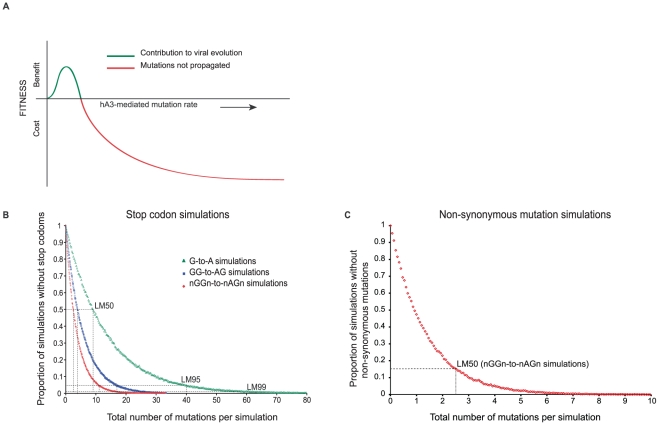

In silico simulation of hA3G-induced mutation in HIV(IIIB) open reading frames.A. Proposed relationship between viral fitness benefit and cost and hA3G mutation rate modified from [3]. When hA3G edits HIV-1 genomes above a particular editing rate, the mutational burden will be too high for the virus and a fitness cost is incurred, depicted in red. However, within a hypothetical window of hA3G activity, marked by the blue line, the extent of editing induced might be low enough for the virus to survive. The additional mutations may help the virus adapt faster in a fluctuating host environment and thus may be considered a viral fittness benefit. B. Each curve represents 100,000 in silico simulations of hA3G-induced mutation of the HIV(IIIB) open reading frames (the virus used in all in vitro experiments) at 100 incremental mutation rates, at which the proportion of sequences escaping in-frame stop codons was assessed. The number of mutations on the x-axis corresponds to the product of the mutation rate and the total number of available targets. Simulations using three different nucleotide targets were performed; (i) G-to-A mutation (n targets = 1362), (ii) GG-to-AG mutation (n targets = 667), and (iii) nGGn-to-nAGn mutation (n targets = 662, with 16 specific nGGn mutation rates from [20]). G-to-A simulations assumed that hA3G would recognized all Gn dinucleotide targets equally, GG-to-AG considered hA3G's preferred di-nucleotide target, while nGGn-to-nAGn simulations considered the 16 previously defined hA3G mutation rates [20] and thus more accurately mirrored the specificity with which hA3G induces mutations in vivo. The number of mutations necessary to induce a stop codon in 50% of viral offspring (LM50) decreased as the accuracy of the hA3G target increased from a single G to a di-nucleotide motif and lastly to a tetra-nucleotide motif. LM50 mutation rates are shown and 95% confidence intervals (CI) are smaller than the data points. C. As in B however here the proportion of simulations without non-synonomous substitutions and the associated LM50 was determined using the defined nGGn-to-nAGn mutation preferences [20].